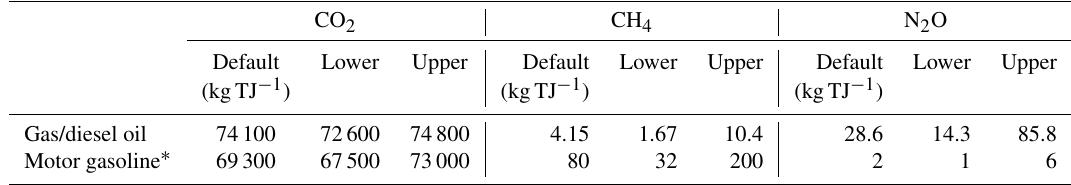
Table 1. Fuel-specific emission factors for agriculture off-road mobile combustion sources and machinery applied (IPCC, 2006).